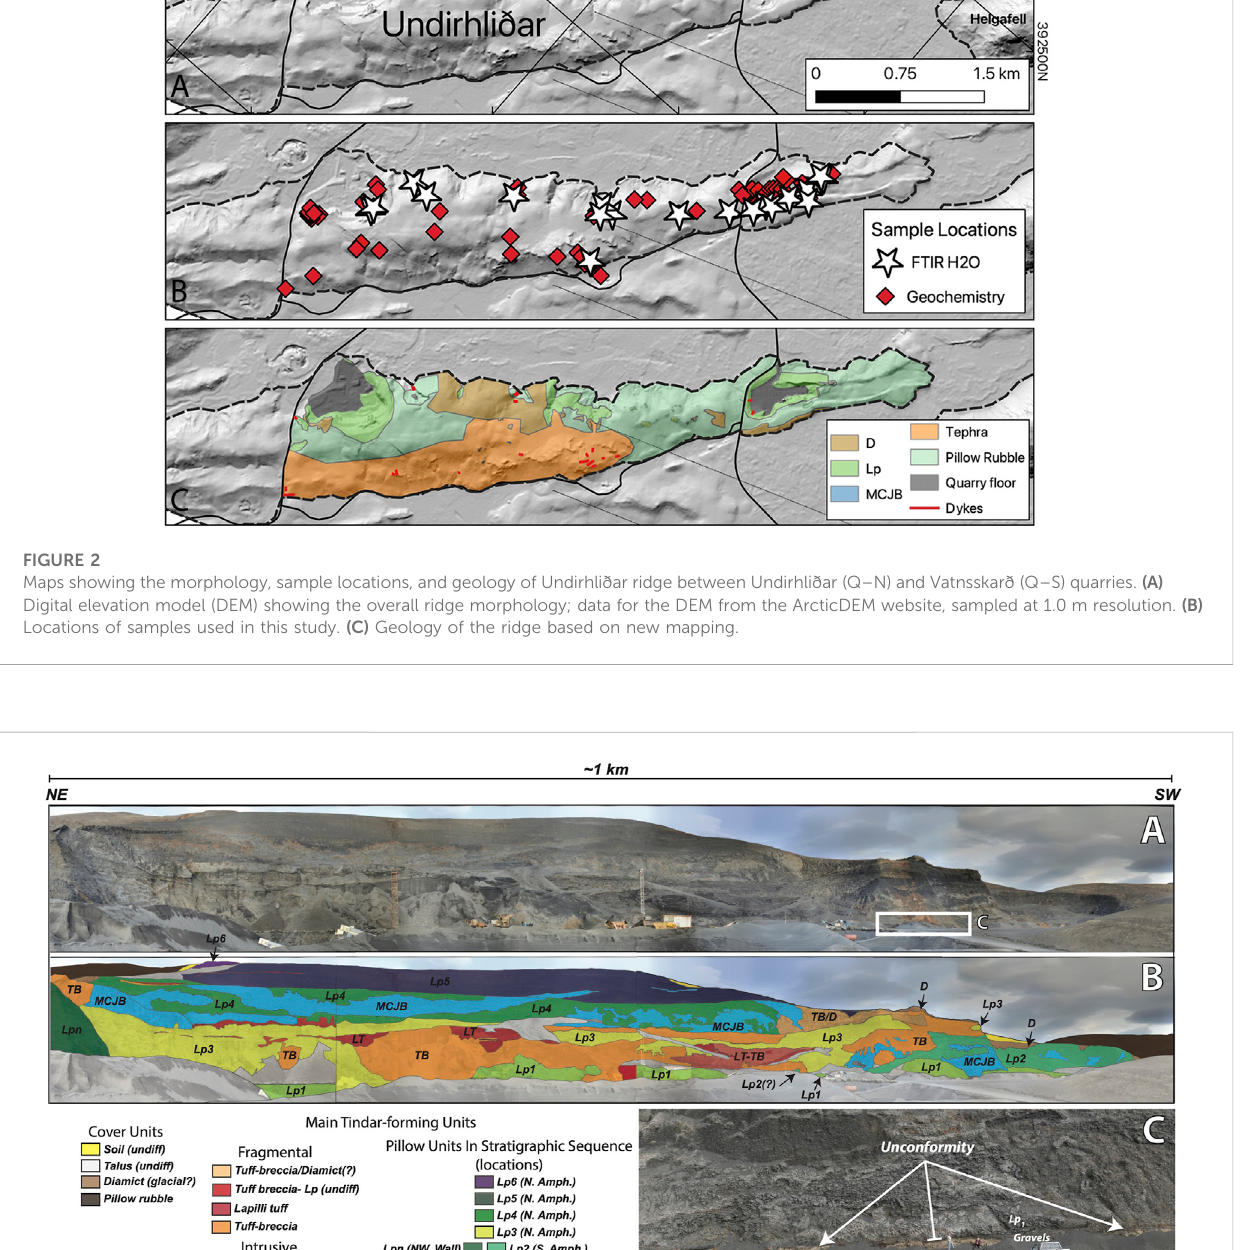
contact of the basal pillows lavas (Lp1) is marked by a thin (cm- scale) layer of vitric tuff and a sharp contact with overlying pillows (Lp2). Lp2 comprises the bulk of the central and southern quarry walls. Within the pillows are isolated lenses of lapilli tuff and vitric tuff-breccia that include glassy basaltic bombs. Above Lp2 is a dark